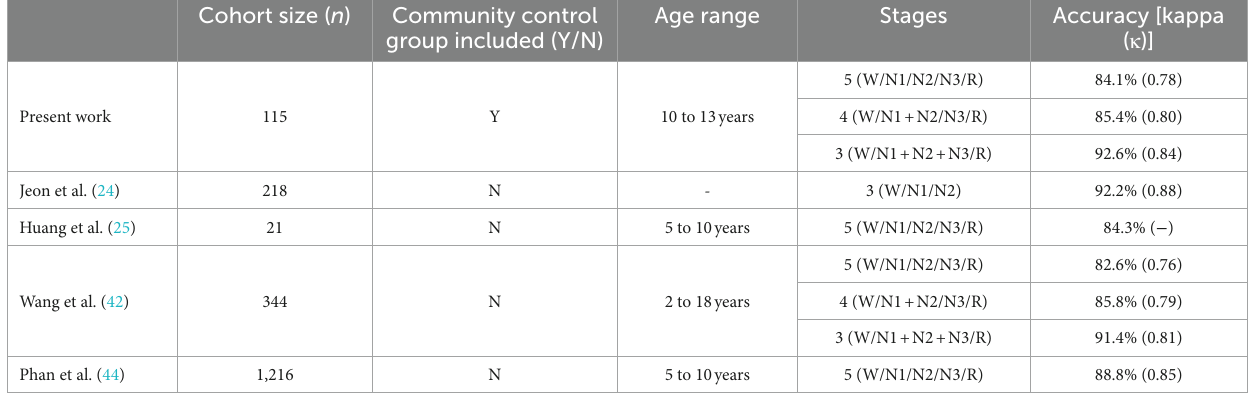
TABLE 5 Performance comparison of the present study with previous deep-learning-based pediatric sleep